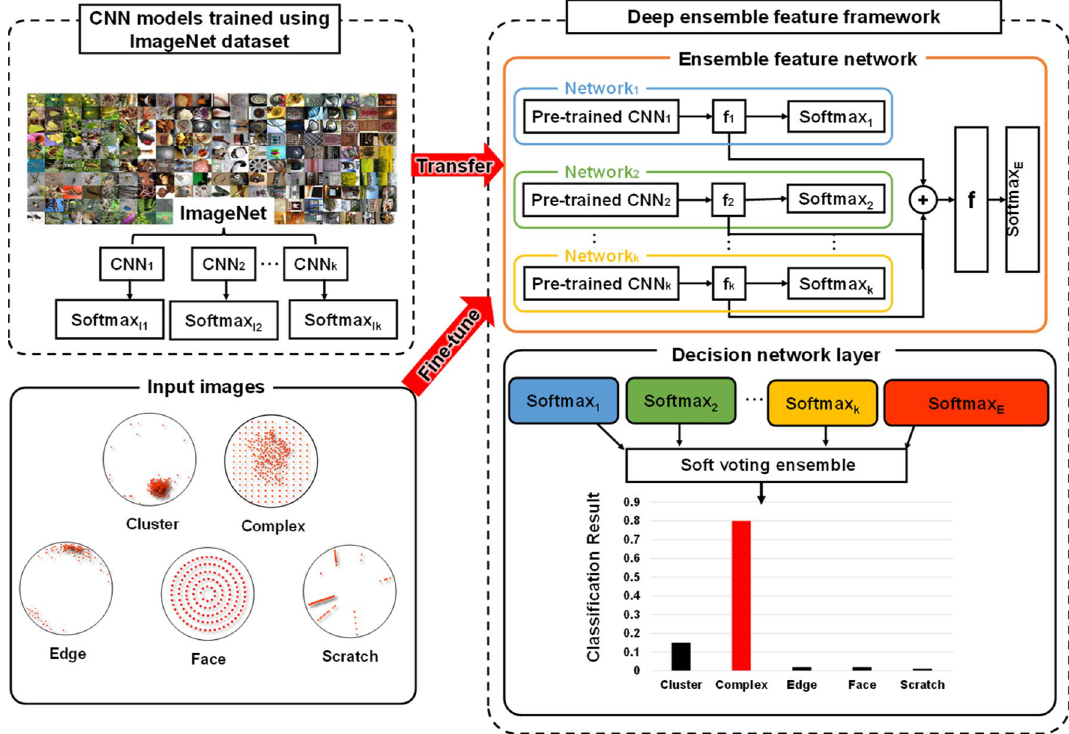
layer for the semiconductor wafer defect